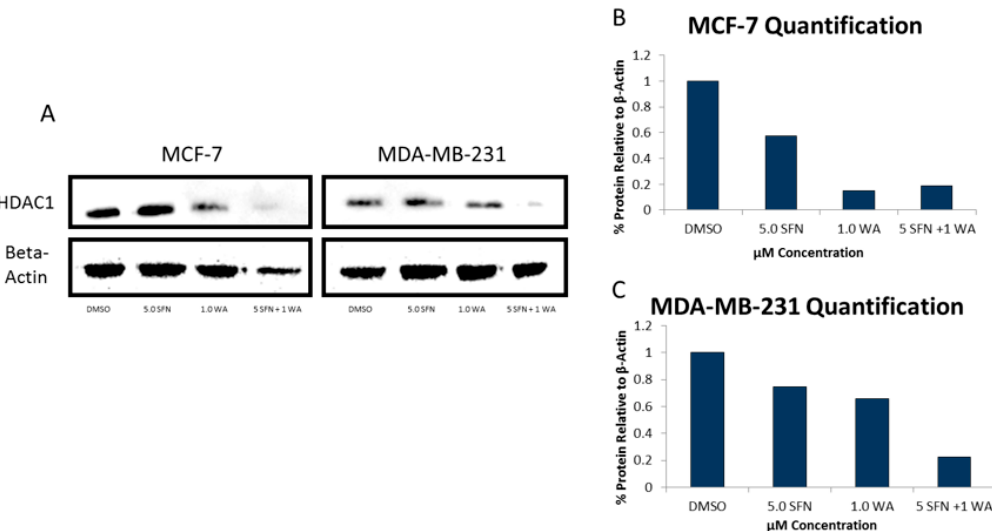
Figure 7. Combinatorial WA and SFN change the expression of HDAC1 at the protein level. ( A ) MCF-7 cells ( left ) and MDA-MB-231 cells ( right ) were treated for 3 days at the indicated concentrations and images are representative. Protein was extracted and used to perform western blot analysis of HDAC1; ( B ) ImageJ was used to quantify results. The results are presented in comparison to β -actin as indicated via the bar graph for MCF-7 cells; ( C ) HDAC1 protein quantification was completed in MDA-MB-231 cells.